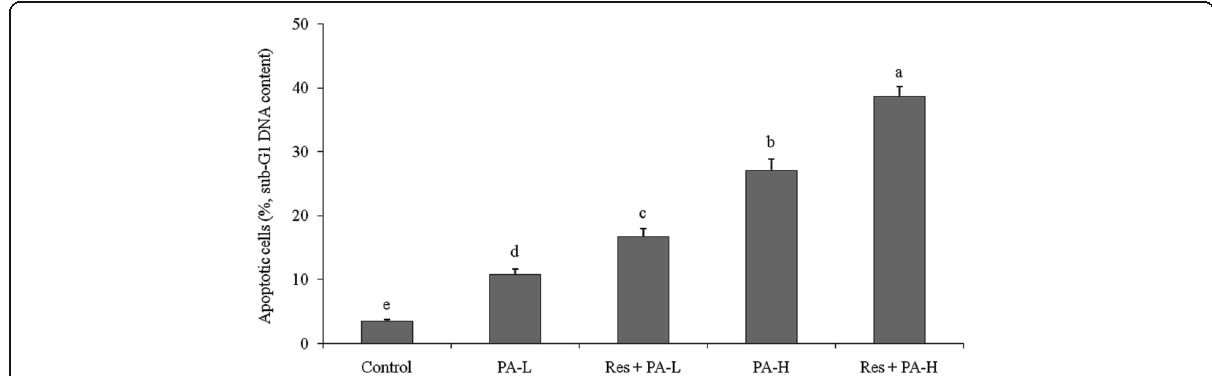
Fig. 3 Apoptosis inducing effects (DNA content of sub-G1) of resveratrol (Res) and paclitaxel (PA) in HepG2 human liver cancer cells. a-e Mean values with different letters over the bars are significantly different ( P < 0.05) according to Dunnett ’ s post-hoc test. PA-L: 5 μ g/mL of paclitaxel; Res + PA-L: 10 μ g/mL of resveratrol +5 μ g/mL of paclitaxel; PA-H: 10 μ g/mL of paclitaxel; Res + PA-H: 10 μ g/mL of resveratrol +10 μ